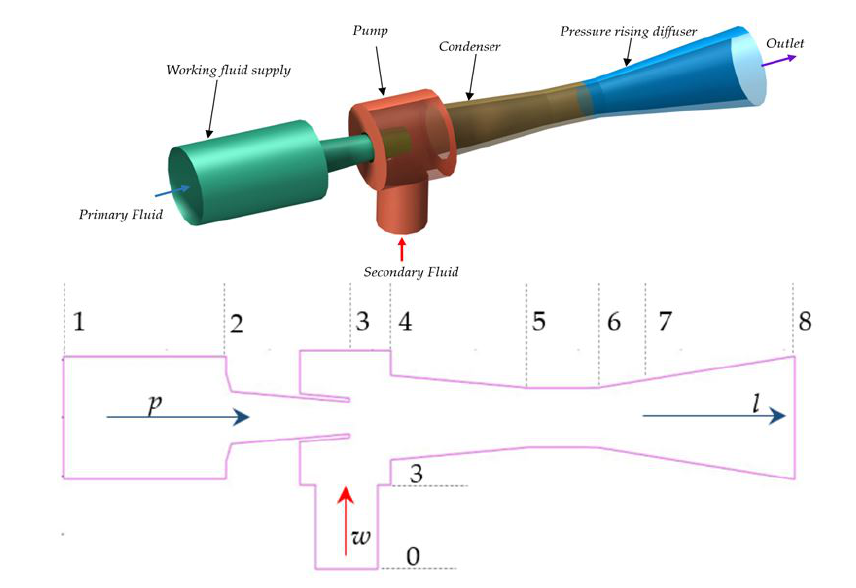
Figure 1. Physical model of